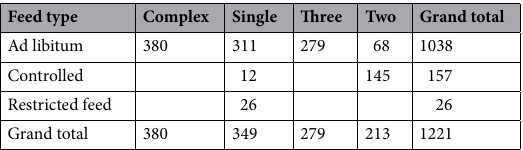
Table 1. Enzyme supplement category based on feeding method.